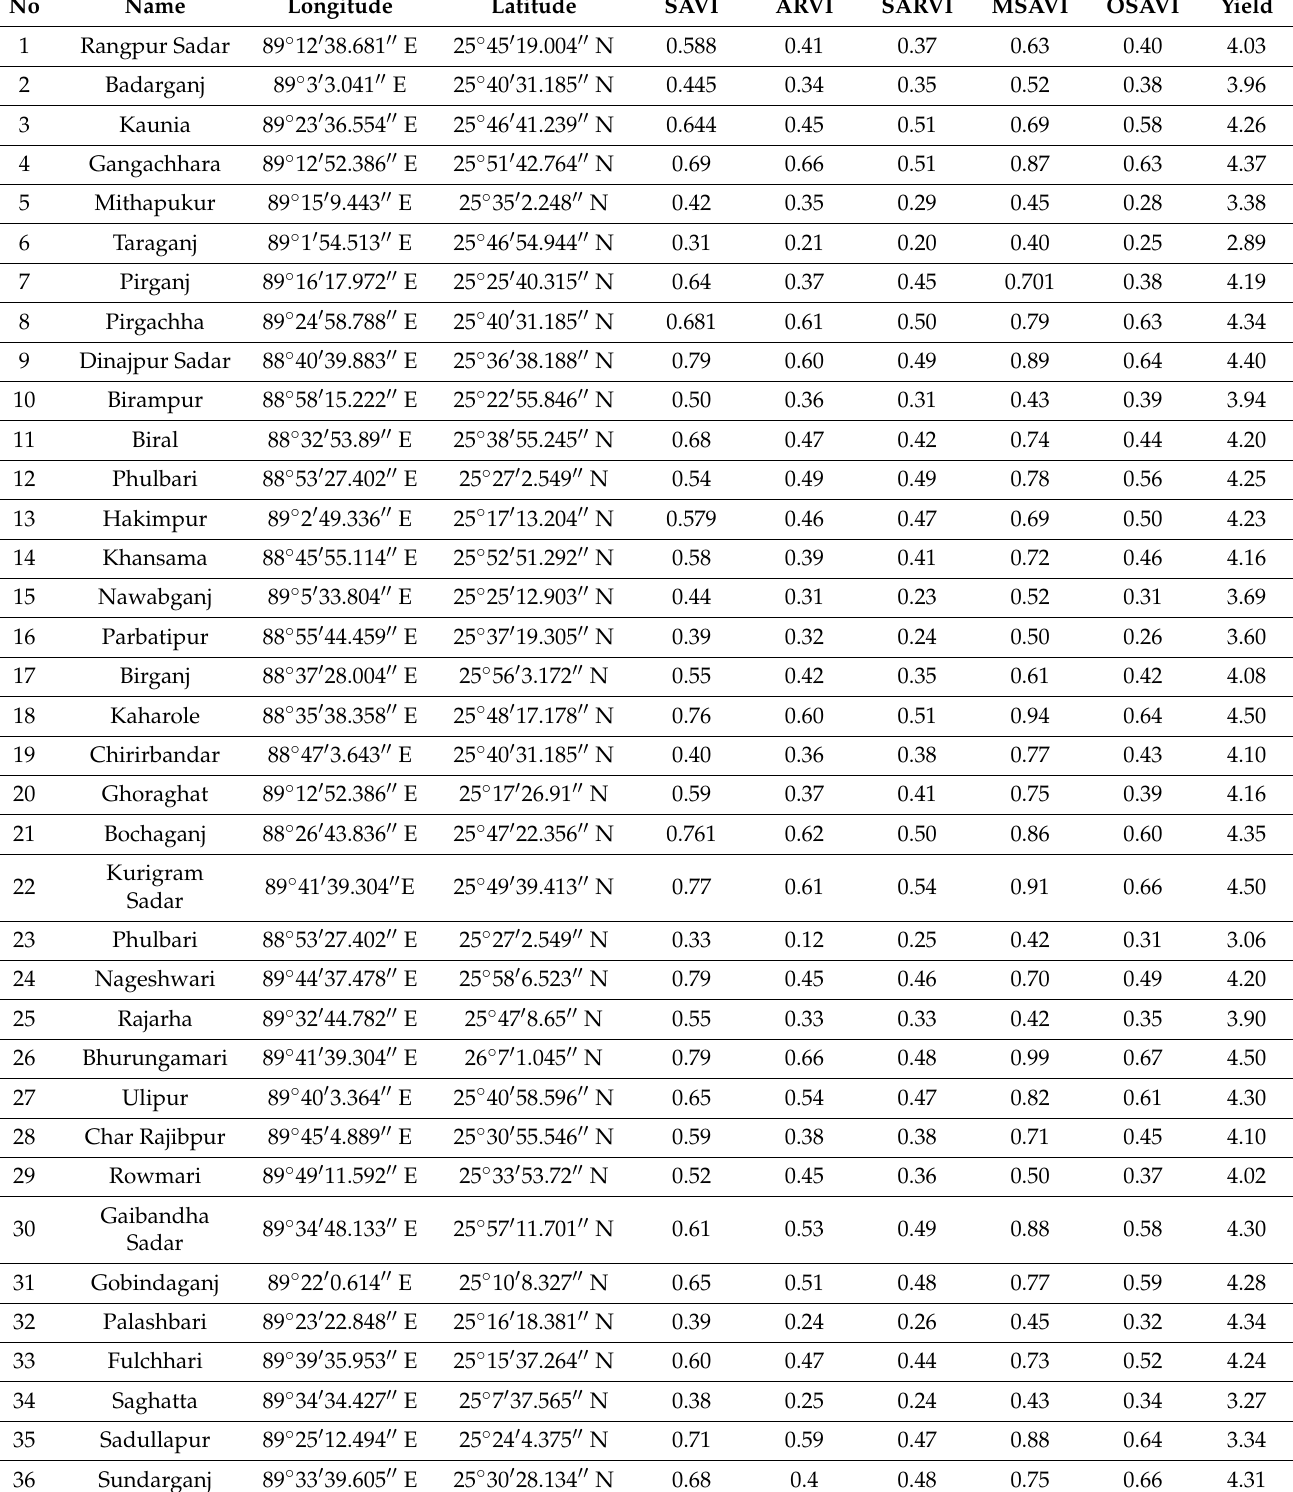
Table 5. Yield estimation based on satellite remote sensing derived soil-vegetation indices for the 36